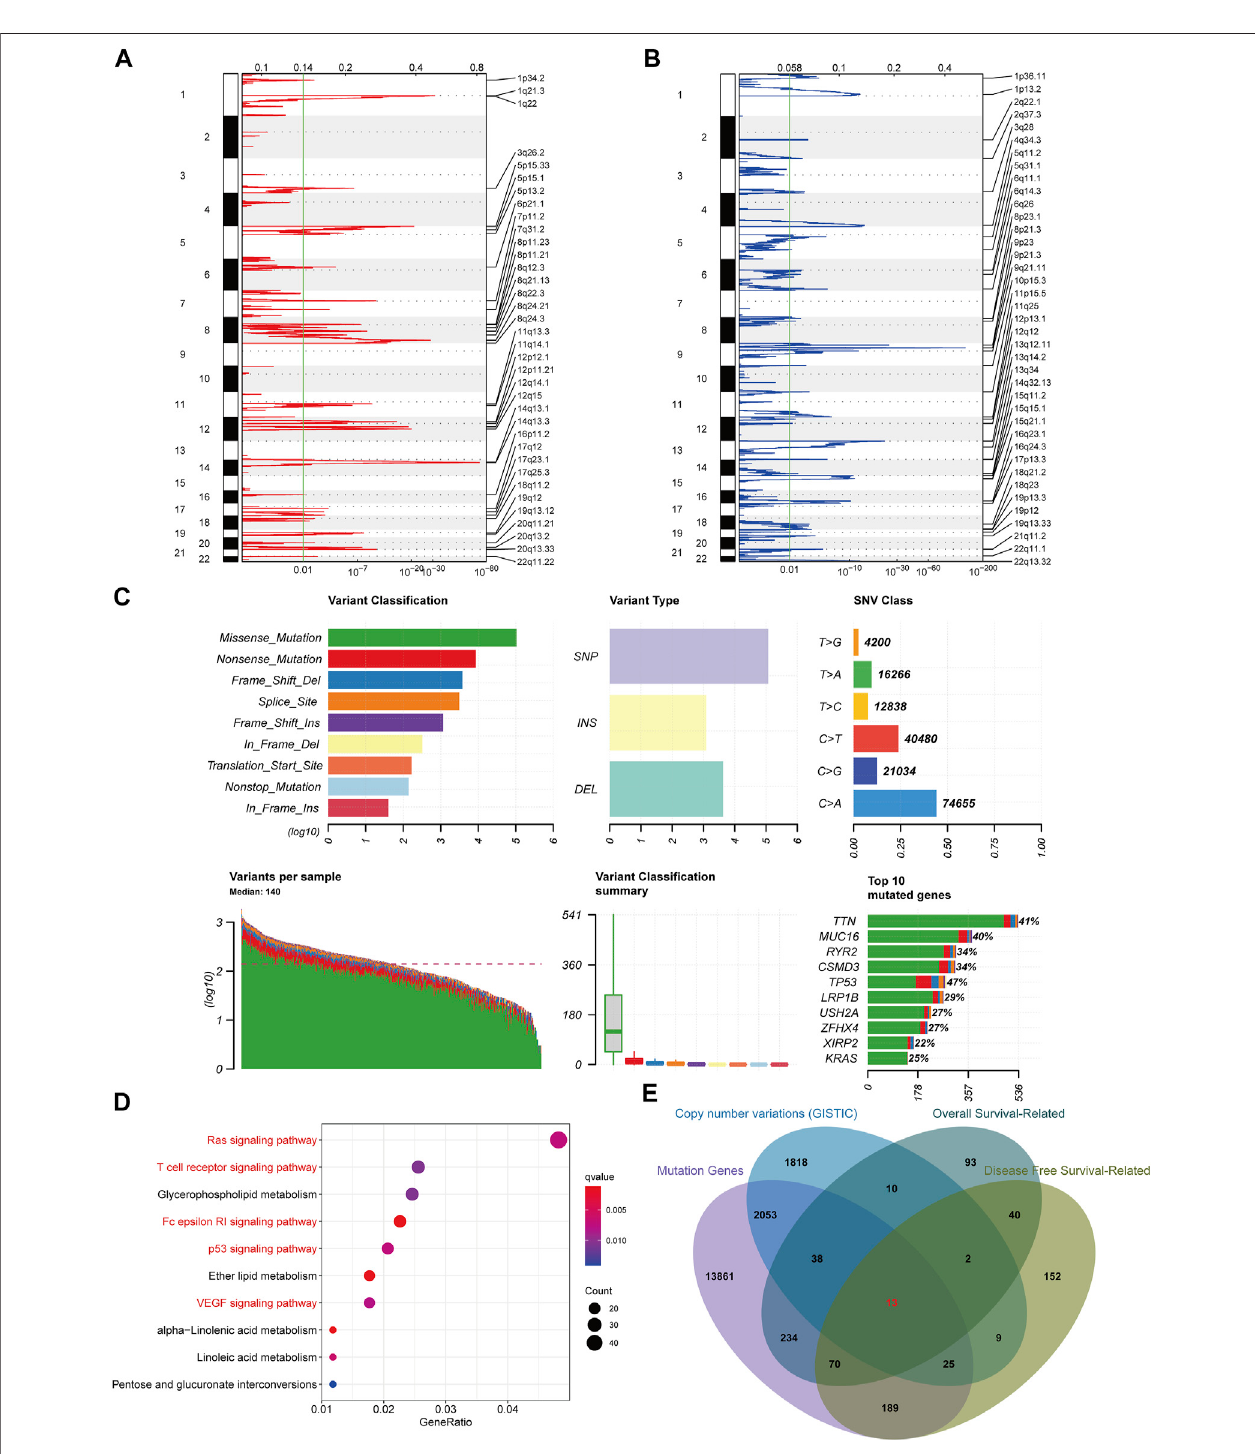
FIGURE1| Screeningforpotentialtumorantigensinlungadenocarcinoma. (A) Identi fi cationofchromosomalcopynumberampli fi cationregions. (B) Identi fi cation ofchromosomalcopynumberdeletionregions. (C) Summaryofgenemutationsinlungadenocarcinoma. (D) KEGGfunctionalenrichmentanalysisofgenesinregionsof chromosomal copy number variation. (E) Identi fi cation of instability genes associated with prognosis.